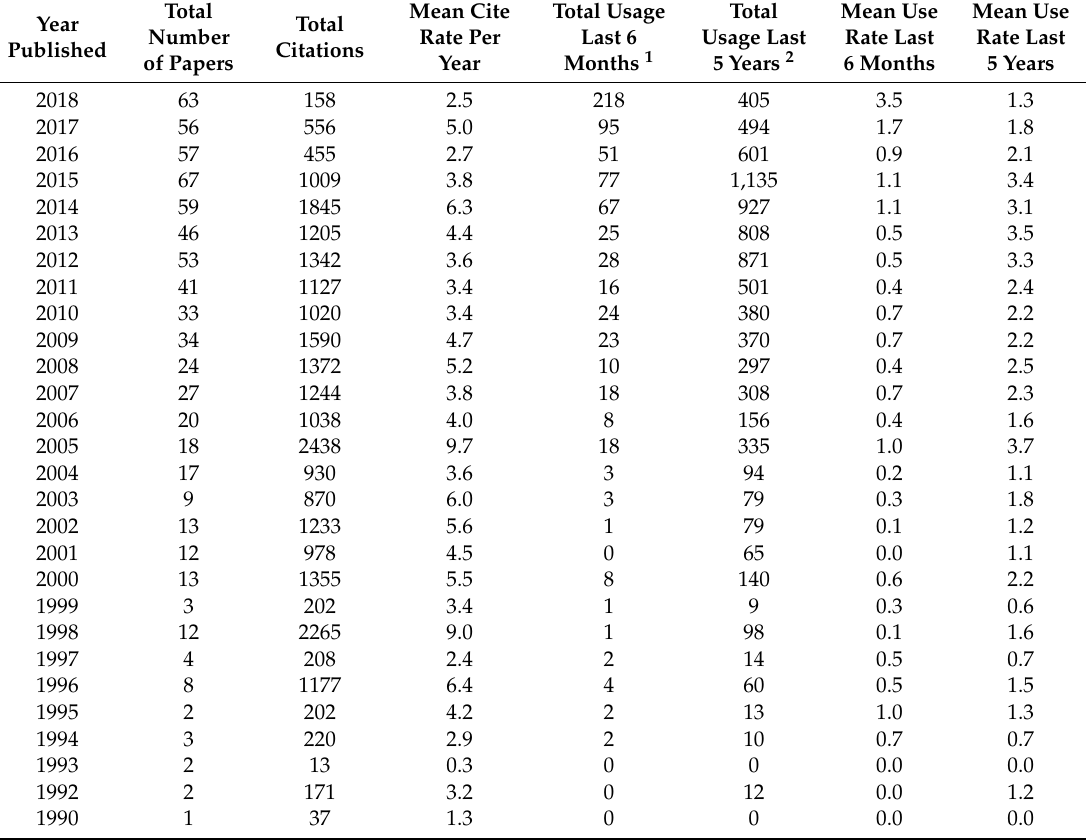
Table 1. General characteristics of publications